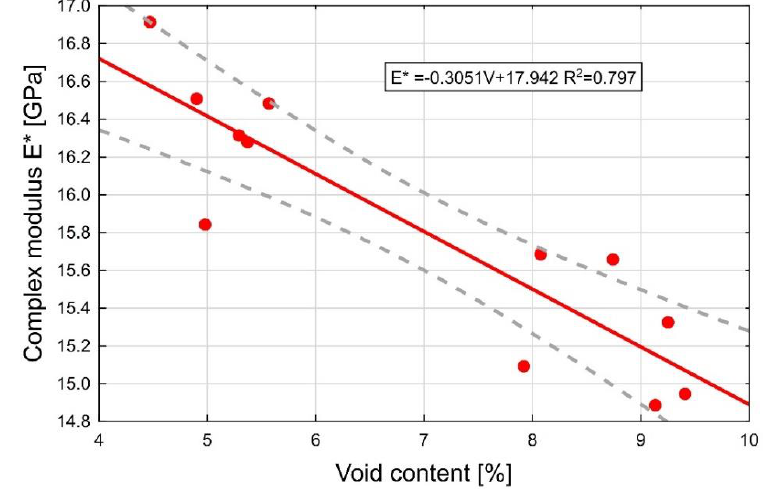
Figure 11. The effect of the air void content in AC 16 W 35/50 asphalt concrete on the complex modulus of the layer.